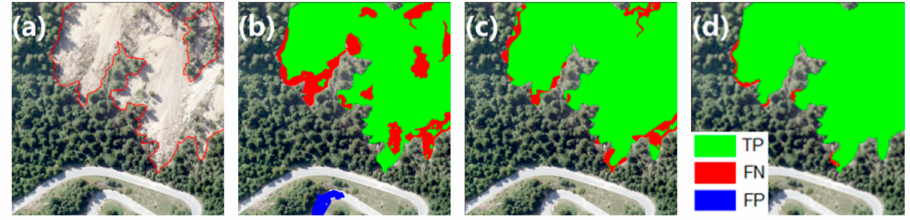
Figure 15. Landslides edge extractions. ( a ) Originally visual interpretation. ( b ) Edge extractions of ResNeXt50. ( c ) Edge extractions of ResNeXt50 + Improved FPN. ( d ) Edge extractions of ResNeXt50 + Improved FPN + L edge